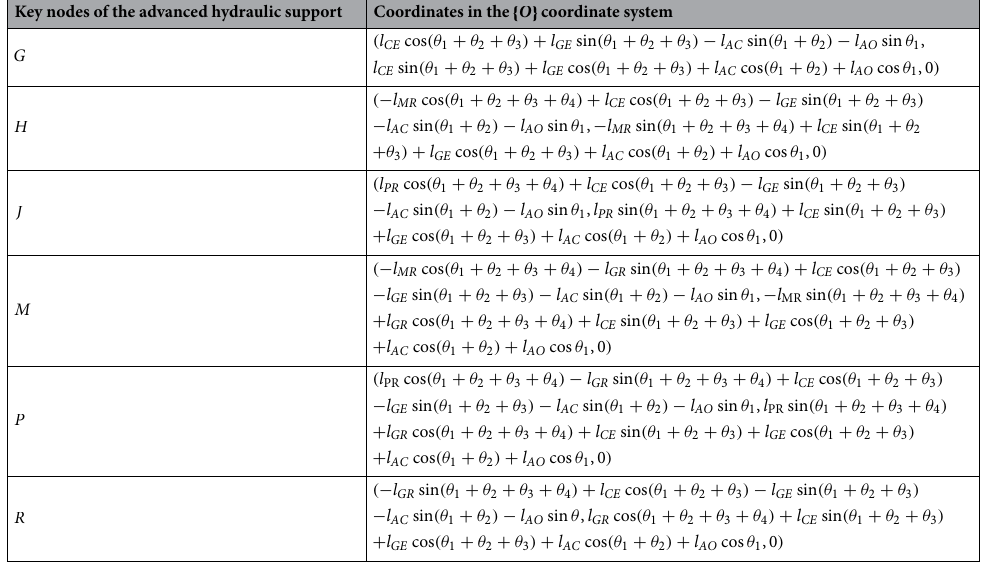
Table 8. Coordinates of nodes G , H , J , M , P , and R in the { O } coordinate system.